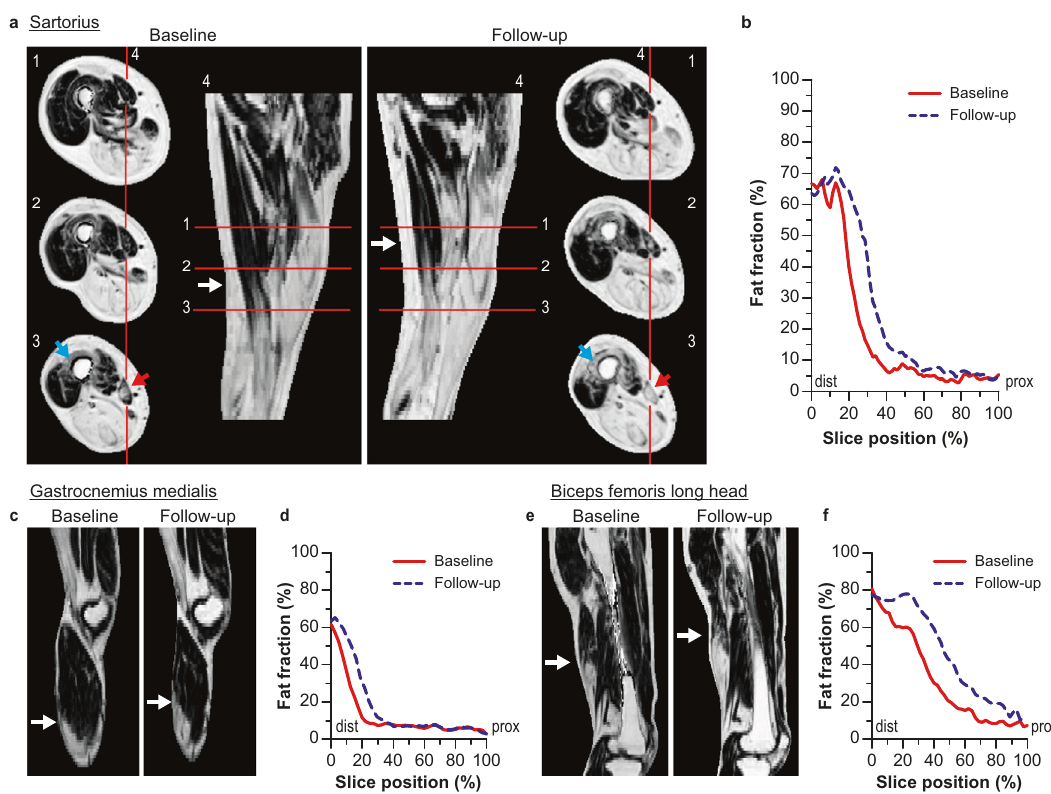
Fig. 4 Typical examples of the proximo-distal progression of the fat-in fi ltrating front in muscles of facioscapulohumeral muscular dystrophy (FSHD) patients. a Axial and sagittal cross-sections of the right upper leg of a 47-year-old male FSHD patient showing fat fraction maps at baseline and obtained after 3.8 years follow-up. They illustrate the progression of fat in fi ltration from distal-to-proximal in the sartorius (red arrows) and vastus intermedius (blue arrow). The position of the fat-in fi ltrating front for the sartorius is depicted with a white arrow in the sagittal view for baseline and follow-up. b Graphical display of quantitative fat fraction curve along the sartorius displayed in fi gure a for baseline (solid, red) and 3.8 years later (dashed, blue). c Sagittal view of fat fraction maps of the leg of a 52-year-old male FSHD patient at baseline and after ~3.8 years. The white arrow indicates the fat front in the right gastrocnemius medialis. d Graphical display of quantitative fat fraction curve along the gastrocnemius medialis displayed in fi gure c at baseline (solid, red line) and 3.8 years later (dashed, blue). e Sagittal view of fat fraction maps of the upper leg of a 66-year-old male FSHD patient at baseline and 3.7 years later. The white arrow indicates the fat front in the right biceps femoris long head. f Graphical display of quantitative fat fraction curve along the biceps femoris long head displayed in fi gure e at baseline (solid, red) and 3.7 years later (dashed,